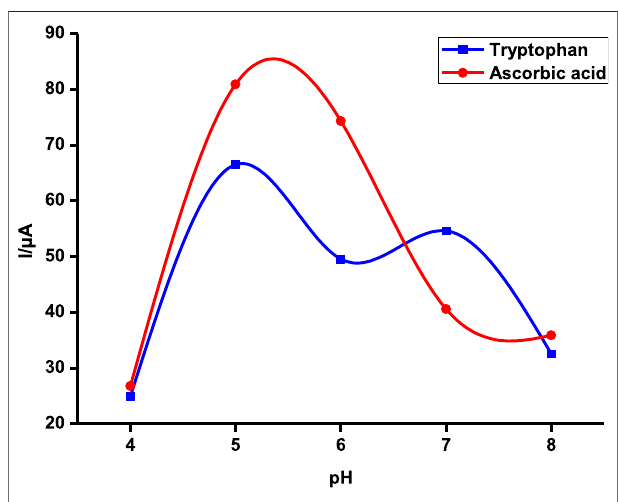
FIGURE 5 | Detection current variation with changes in pH on poly- CoTCPc-CoTAPc-GONS/GCE in the buffer solution at a scan rate of 100